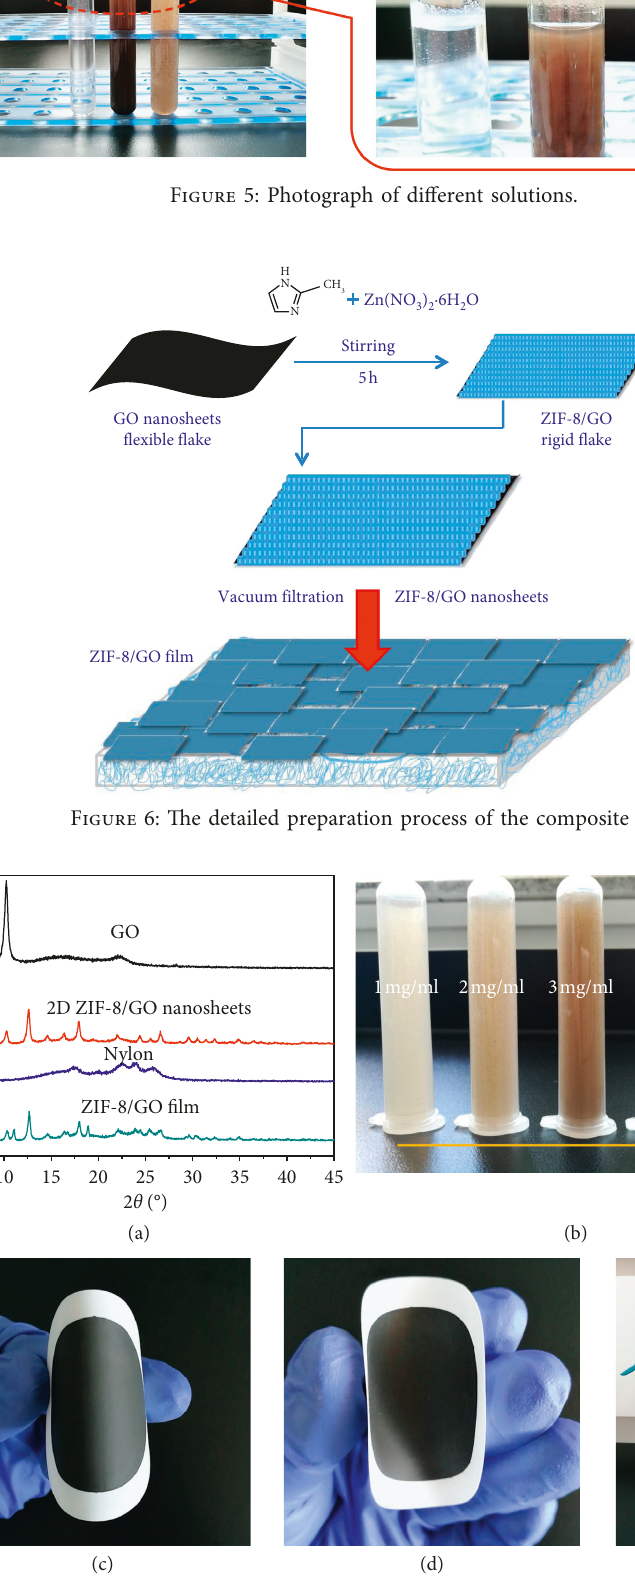
Figure 7: (a) XRD spectra of different materials. (b) Photograph of ZIF-8/GO solution of different concentrations. (c) Outward flexibility and (d) inward flexibility of the ZIF-8/GO film. (e) Photograph of the equipment used in the preparation